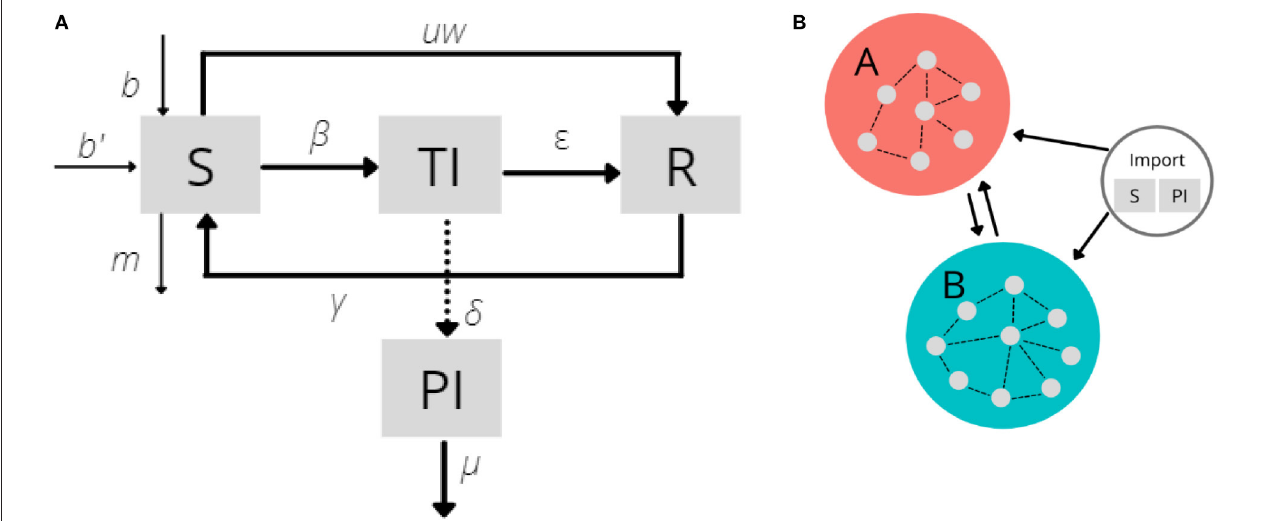
FIGURE 2 | Flow diagram of animal’s transition between compartments and group. (A) Compartment model of animal transition. Consist of susceptible (S), transiently infected (TI), persistently infected (PI), and recovered (R). (B) Metapopulation dynamics between groups. Dots inside the circle represent farms and its connections. New animals introduced from imports are susceptible and persistently infected.